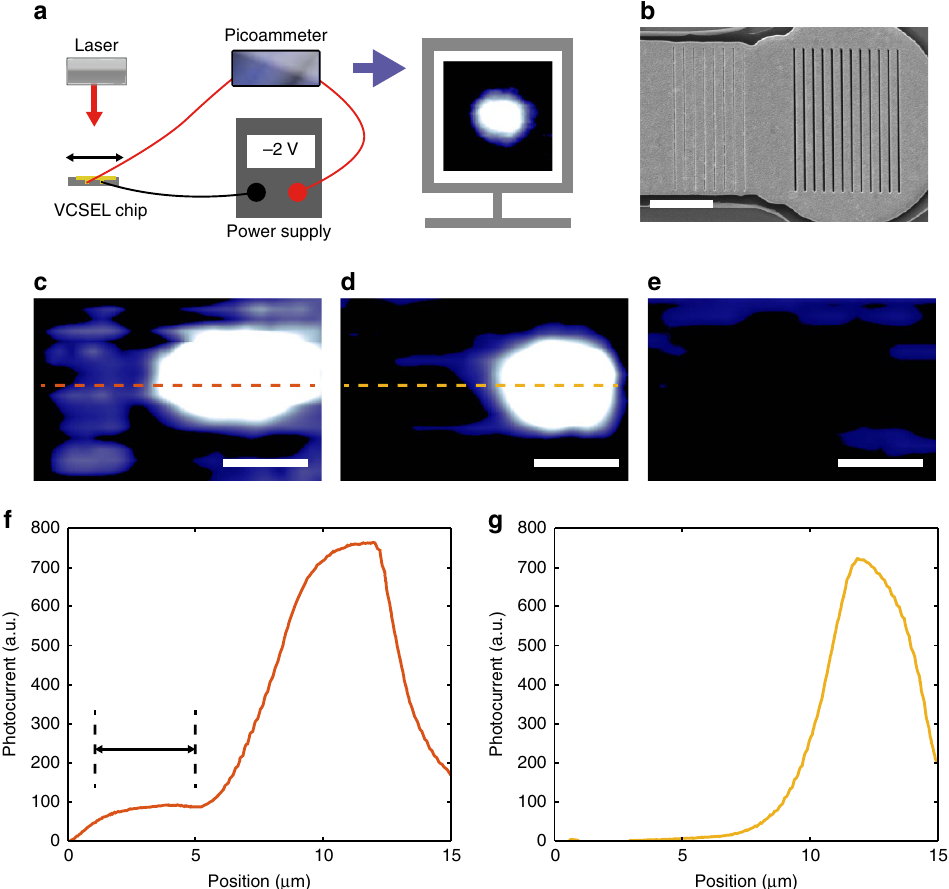
Figure 6 | SPP detection by a VCSEL. ( a ) The set-up for detecting spatially resolved photocurrent by raster scanning a diffraction limited laser beam across a reverse-biased VCSEL. ( b ) Scanning electron microscope image of the groove (eight grooves of a 50nm width with an 800nm period) and slit (twelve slits of 100nm width with a 760nm period) gratings milled into a waveguide and plasmonic VCSEL, respectively. ( c – e ) Photocurrent maps recorded with ( c , d ) the light polarized perpendicularly to and ( e ) along the grooves and slits for the device with ( c , e ) both gratings and ( d ) a slit grating only. ( f ) and ( g ) are the cross-sections of ( c ) and ( d ), respectively, and are marked with dashed lines. The position of the groove grating is indicated in ( f ) with a line. Scale bars, 5 m m in all images. a.u., arbitrary